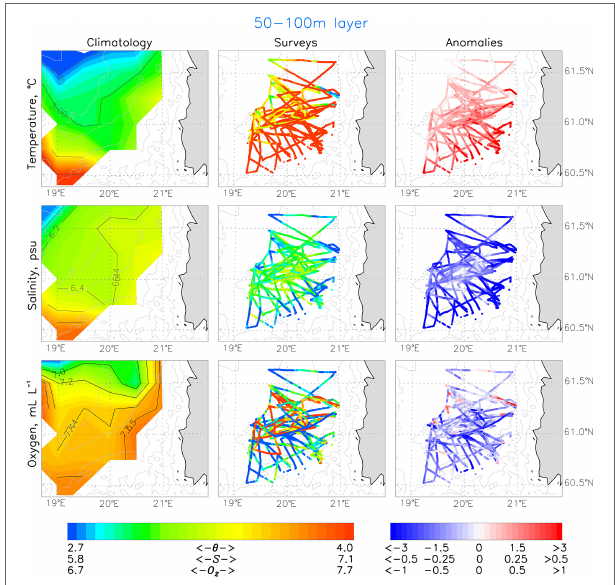
FIGURE 10 | Maps of 50-100m mean water temperature, salinity and dissolved oxygen from (left) July-October climatology, (middle) glider observations, and (right) anomalies computed as differences between glider observations minus climatology taken for the month corresponding to each individual glider